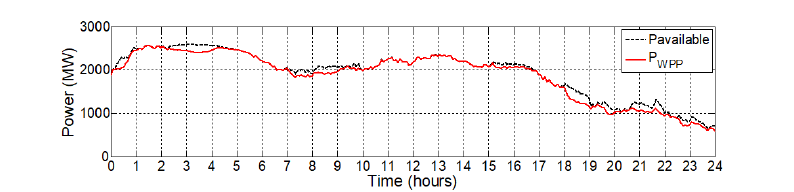
Figure 9. Available and generated wind power.